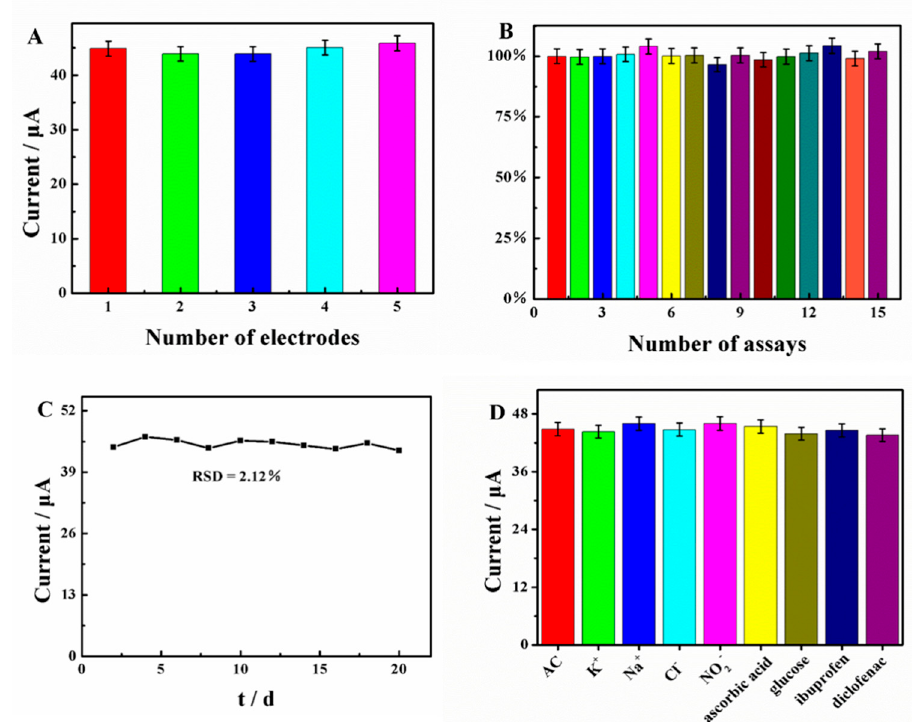
Figure 8. ( A ) Current response of five independent N-SC/ β -CD-MOFs/GCEs toward 20.0 μ M AC; ( B ) Current response of one N-SC/ β -CD-MOFs/GCE toward 20.0 μ M AC for successively 15 times; ( C ) Current response of one N-SC/ β -CD-MOFs/GCE toward 20.0 μ M AC over 20 days; ( D ) Current response of N-SC/ β -CD-MOFs/GCE toward 20.0 μ M AC in the presence of other potential inter- ferents.